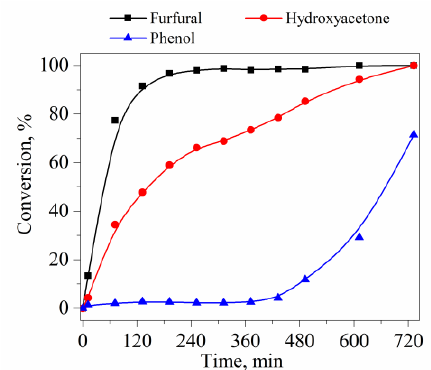
Figure 11. Effect of the reaction time on the conversion of furfuryl, hydroxyacetone, and phenol during the hydrotreatment of mixed model conversion (180 °C, 3.5 MPa).